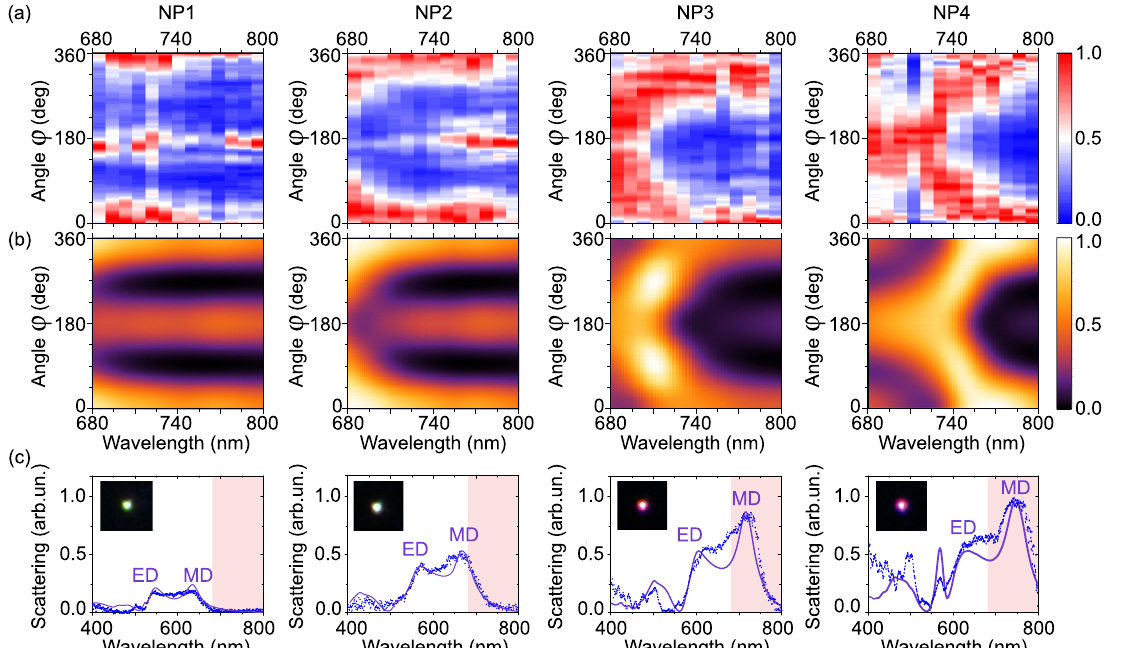
Figure 3: Measured (a) and calculated (b) efficiencies of the BSW excitation as a function of the pump wavelength and the azimuthal angle for various nanoparticle (NP) sizes. (c) Experimental (dots) and calculated (curves) scattering spectra of the particles: ED is electric dipole resonance; MD is magnetic dipole resonance. The insets show dark-field images of the particles; the shaded areas demonstrate the spectral range of the BFP